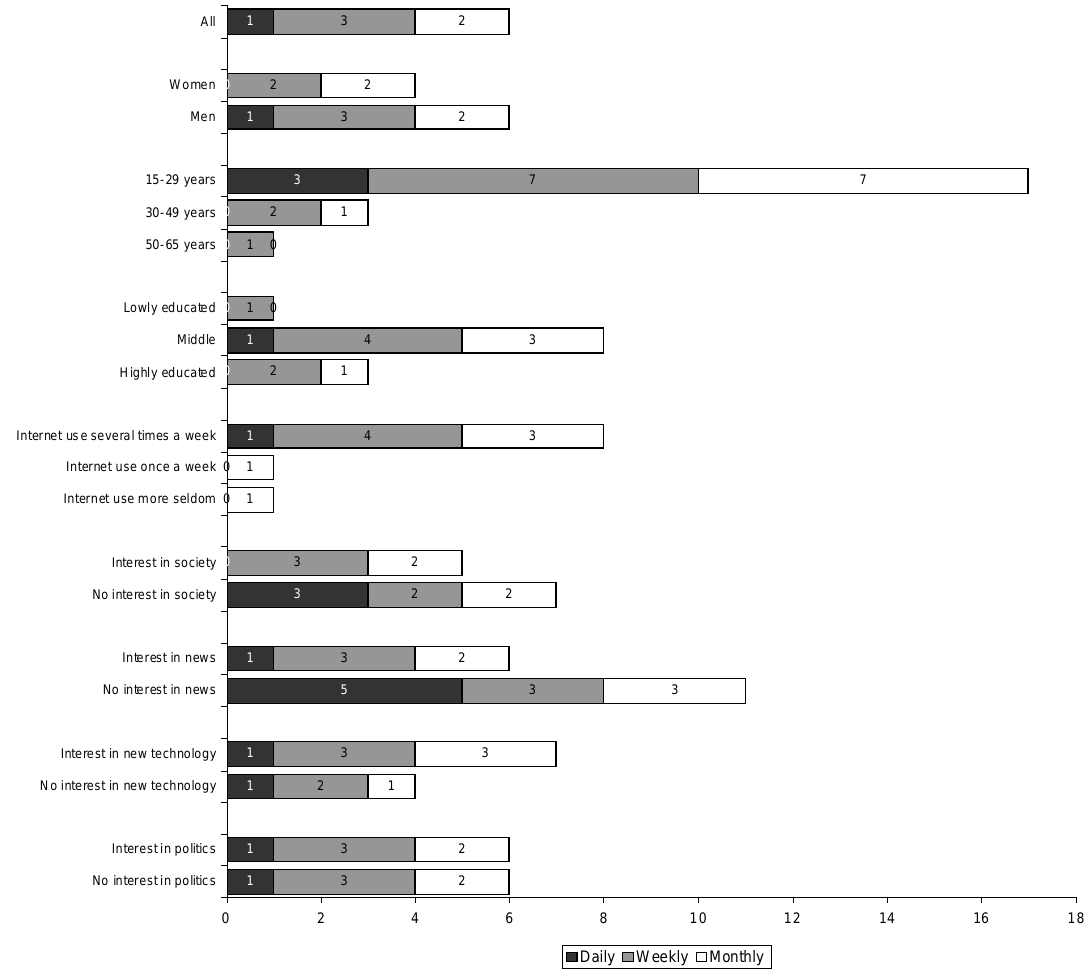
Figure 3: Blog-writing in different groups of the Swedish population (per cent and